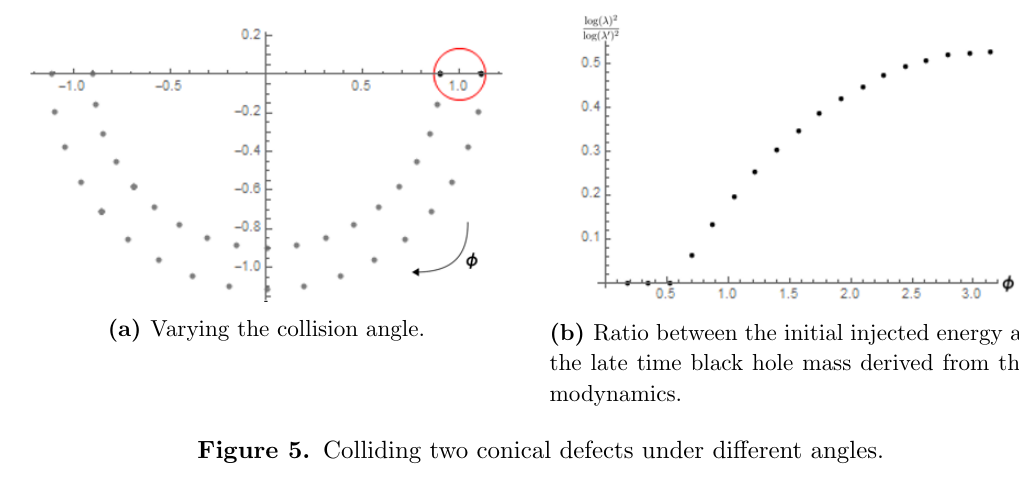
Figure 5. Colliding two conical defects under di(cid:11)erent